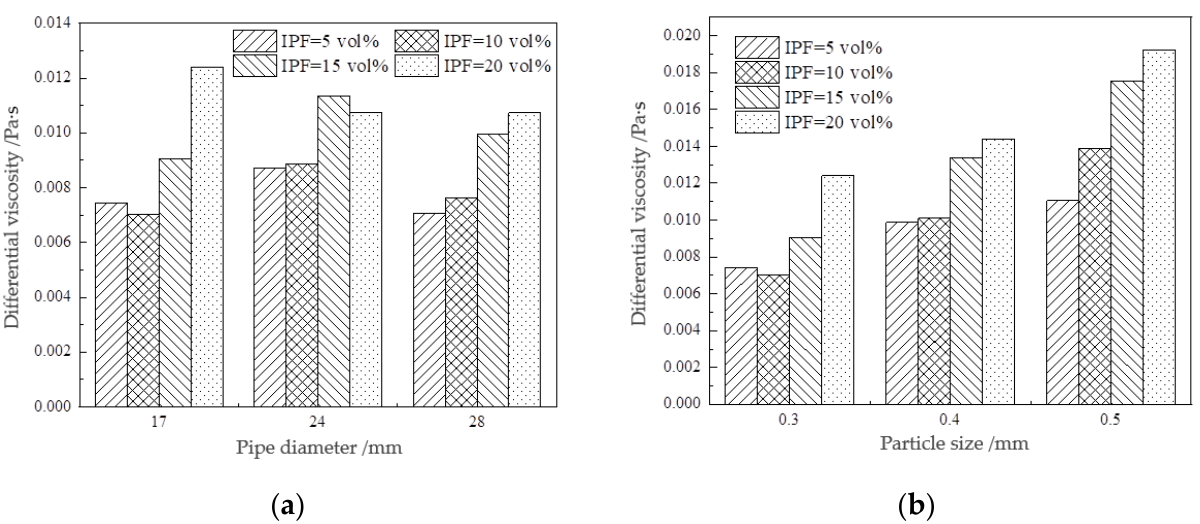
Figure 8. Factors affecting viscosity. ( a ) The relationship between viscosity and pipe diameter; and ( b ) the relationship between viscosity and particle size.